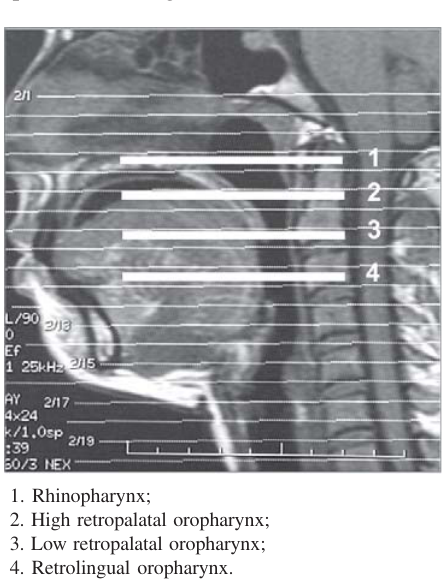
Figure 4 - Planning of axial images for measurements of air column